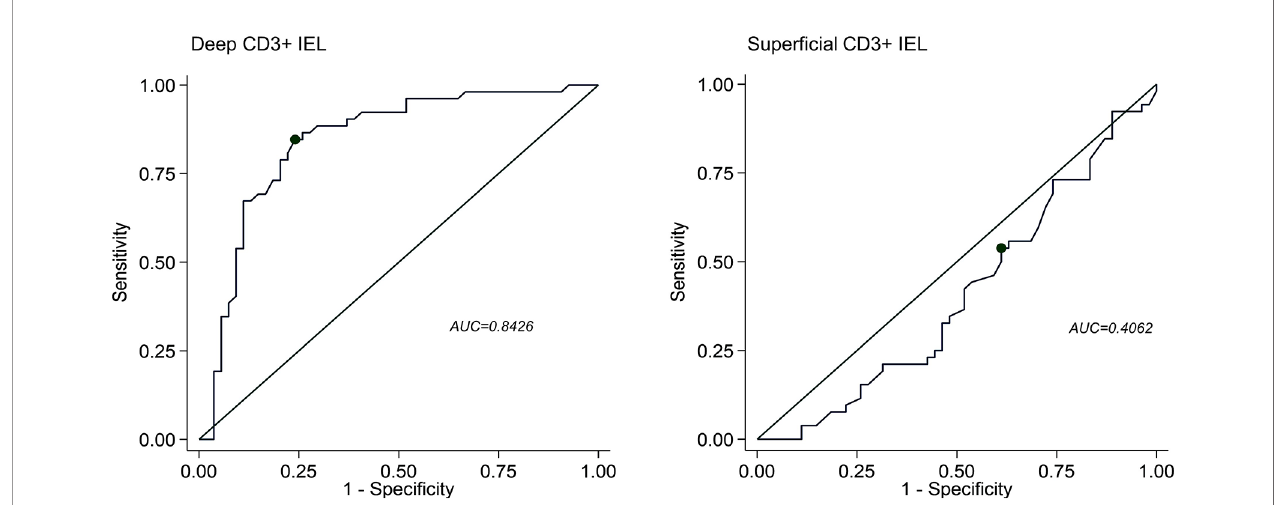
FIGURE 3 | Receiving operating characteristics (ROC) curves discriminating patients with autoimmune gastritis (AIG) compared to healthy controls, H. pylori gastritis, active celiac disease, and Hashimoto ’ s thyroiditis according to deep (right panel) or super fi cial (left panel) CD3+ intraepithelial lymphocyte (IEL) in fi ltration. AUC, area under